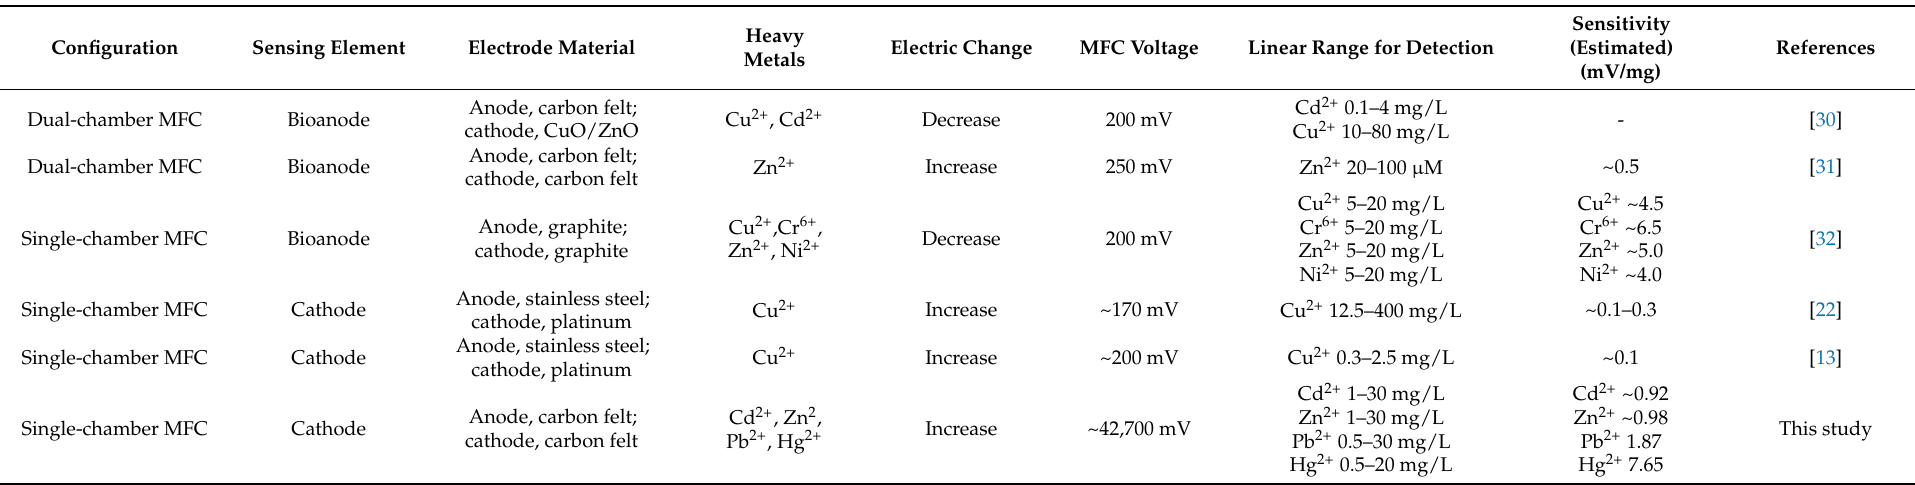
Table 1. Comparison of the analytical performance of representative MFC-based sensing systems reported